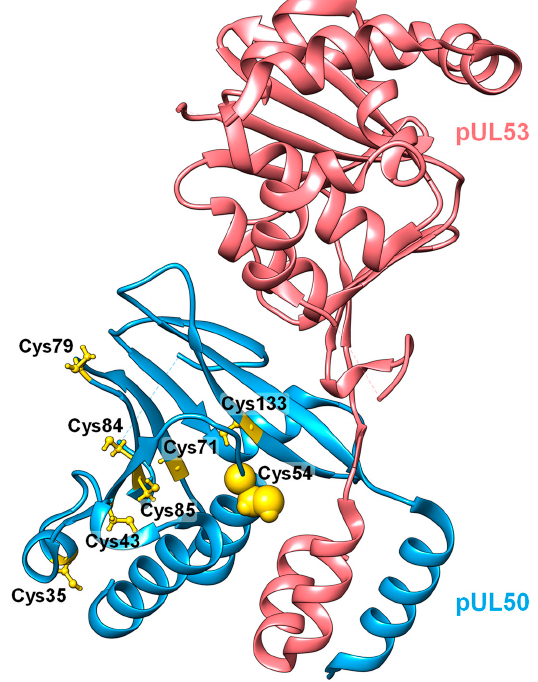
Figure 3. Protein complex structure of pUL53 and pUL50 from HCMV (PDB ID code: 5D5N [43]). HCMV pUL53 (red) interacts with pUL50 (blue) via a hook-like element that binds into an α -helical groove on pUL50. Cysteine residues in pUL50 are depicted with a yellow ball-and- stick representation, while Cys54, which is the only one of the eight cysteines located at the interaction interface with pUL53, is highlighted with spheres. Protein visualization was performed with UCSF Chimera [67] (version